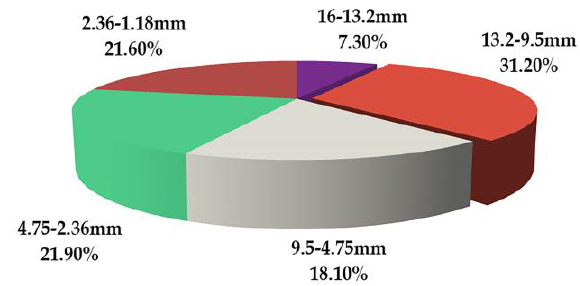
Figure 16. Contribution rate of coarse aggregates of different sizes for x-axis rutting deformation.